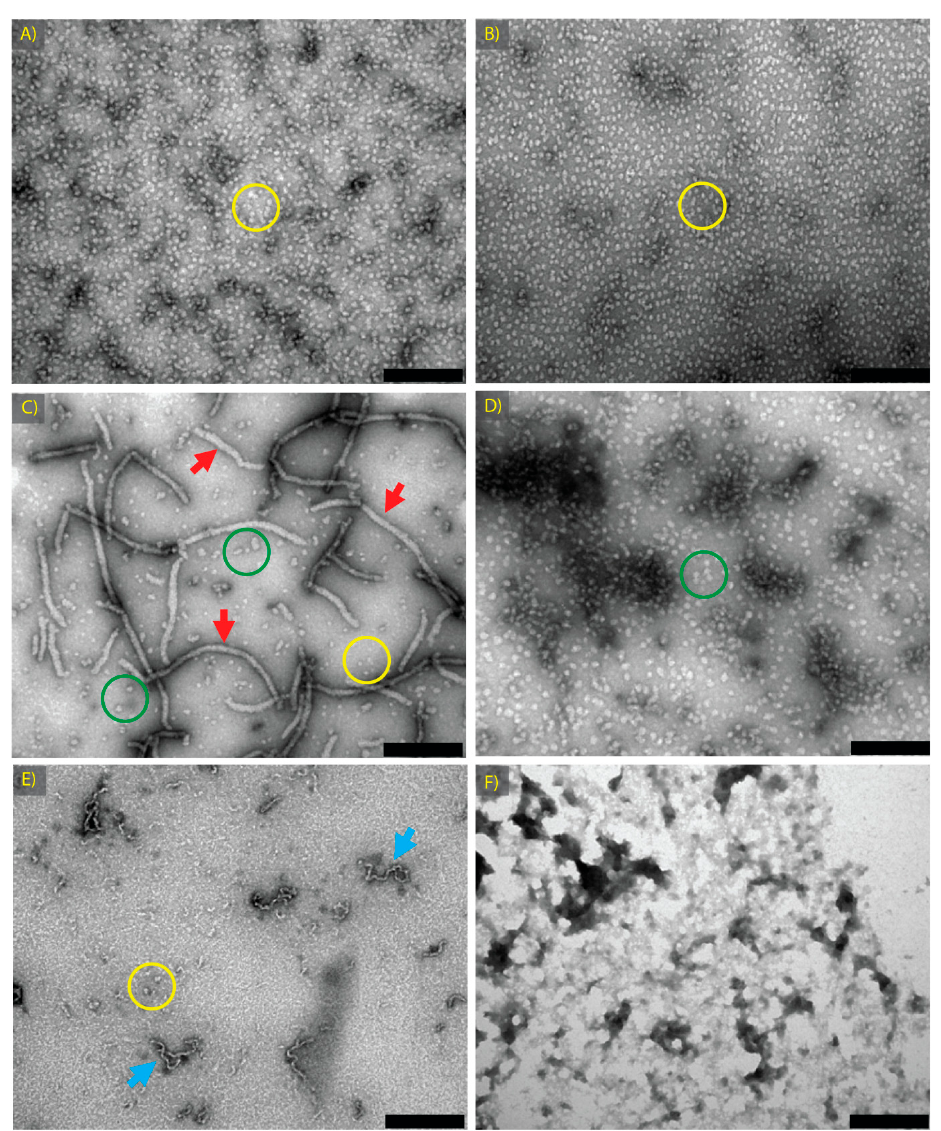
Figure 2. Transmission electron microscopy (TEM) images of samples formed to assess the effects of structural variation on the chaperone activity of α -crystallin: ( A ) α Native; ( B ) α GdnHCl Native; ( C ) α Fibril; ( D ) α Amorphous; samples of α -crystallin. ( E ) β H Fibril; and ( F ) aldehyde dehydrogenase (ADH) Amorphous samples. All samples were prepared as described in Table 1. Scale bars are 200 nm. Features of importance are highlighted, including long amyloid fibrils (red arrows), curvilinear amyloid fibrils (blue arrows) and spherical aggregates of ~15 nm in diameter (yellow circles) or larger spherical aggregates (green circles).